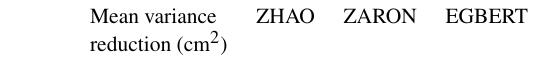
Table C1. Mean variance reduction for J2 and C2 altimeter databases, within each IT region, when using the different S 2 internal-tide models and compared to the ZERO correction case; variance reduction in altimeter SLA (white lines) and for altimeter crossover differences (italic lines) for each mission, in square cen- timeters (0 is for | value | <0.005cm 2 ). For each IT region, the max- imum variance reduction across the different models is highlighted in